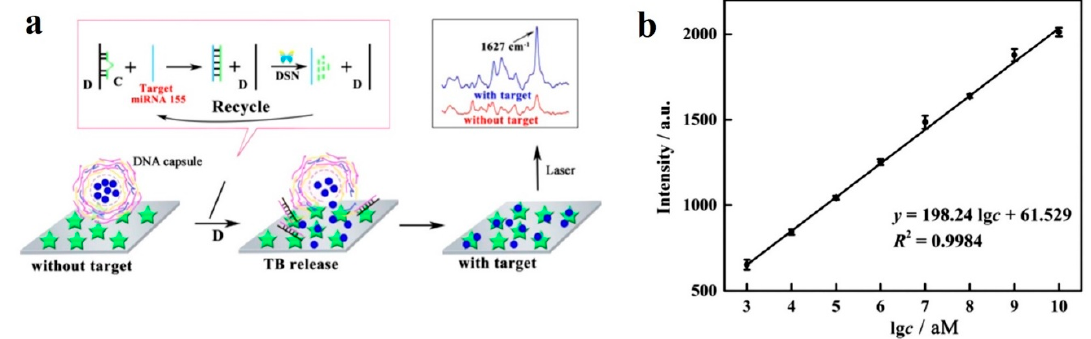
Figure 11. ( a ) SERS sensing of miR-155 using DNA microcapsules and DSN amplification. ( b ) Linear curve of Raman intensity (1627 cm − 1 ) for concentrations of miR-155 from 1 fM to 10 nM. ( a , b ) Adapted with permission [72]. Copyright 2018 American Chemical Society.